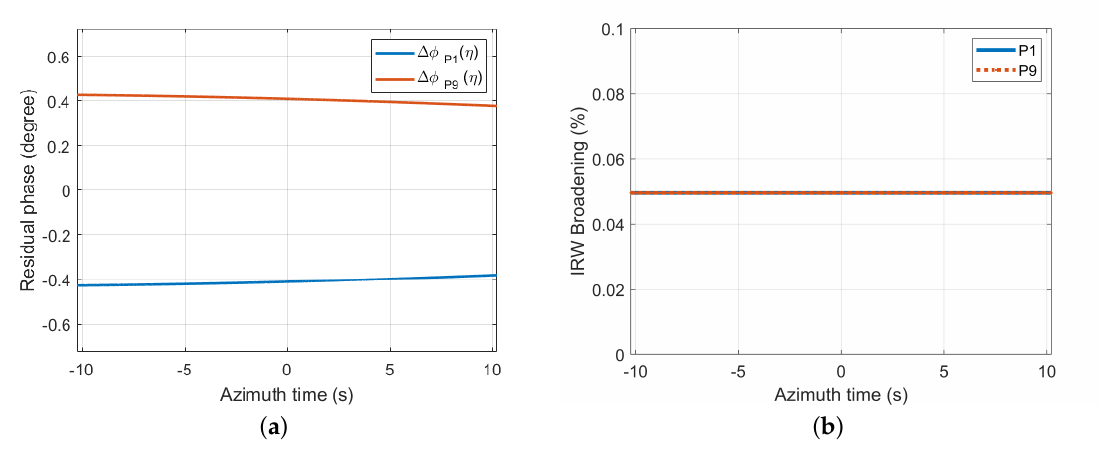
Figure 6. ( a ) The phase error ∆ φ P 1 and ∆ φ P 9 versus azimuth time. ( b ) IRW broadening of target P1 and P9 versus azimuth time.